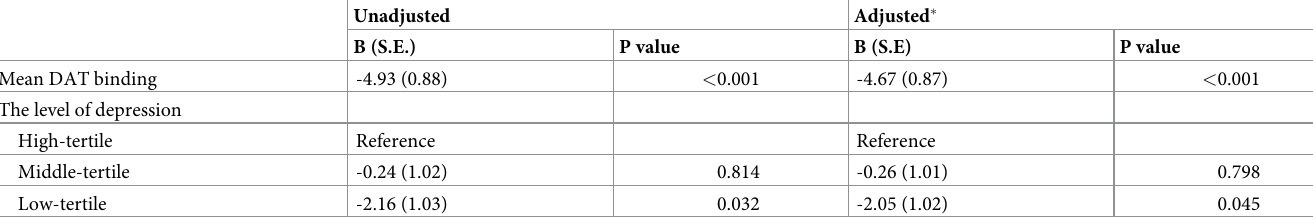
Table 3. Influence of depression level and dopamine transporter binding in the posterior putamen on UPDRS-motor